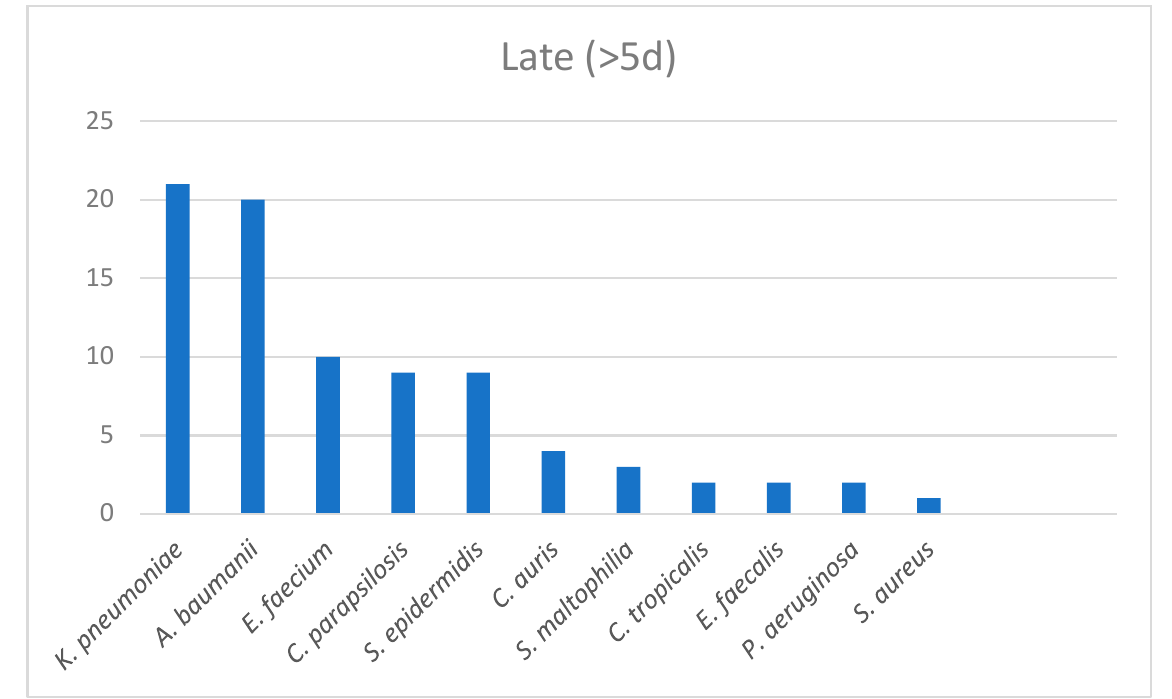
Figure 4. LHA group infections epidemiology